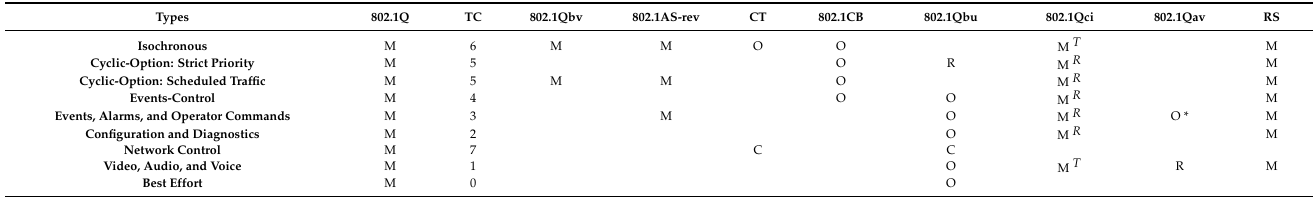
Table 3. Traffic mapping [13]. TC: traffic class, CT: cut-through, RS: reservation scheduling, M: mandatory, O: optional, C: conditional, R: recommended, T : time-based, R : rate-based, *: end